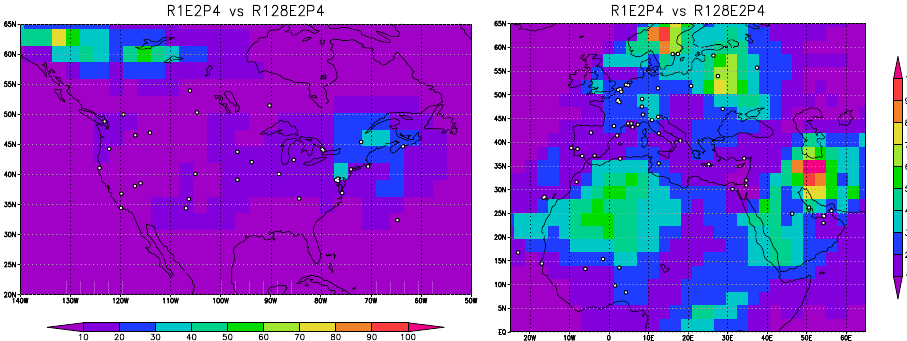
Fig. 6. Time-averaged differences [%] in AOT, for n ens = 20 ,n patch = 4 experiments. The black & white dots represent AERONET sites.